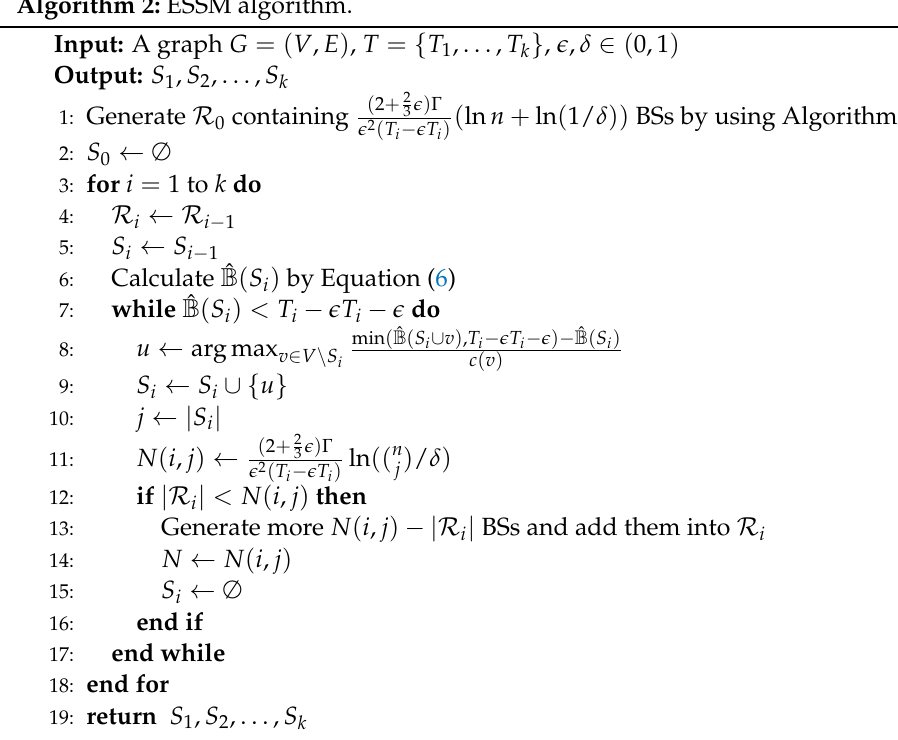
Algorithm 2: ESSM